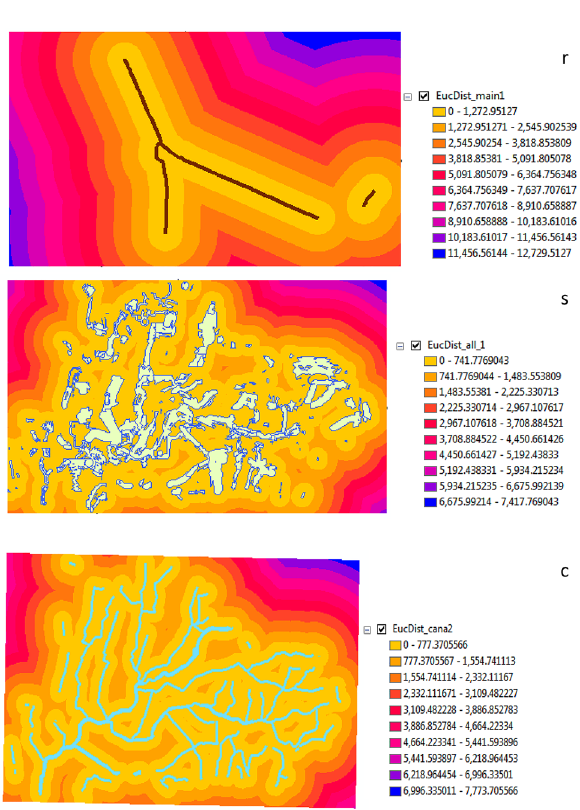
Figure 7. Euclidean distance: (r) for main road (s) for all sites (c) for